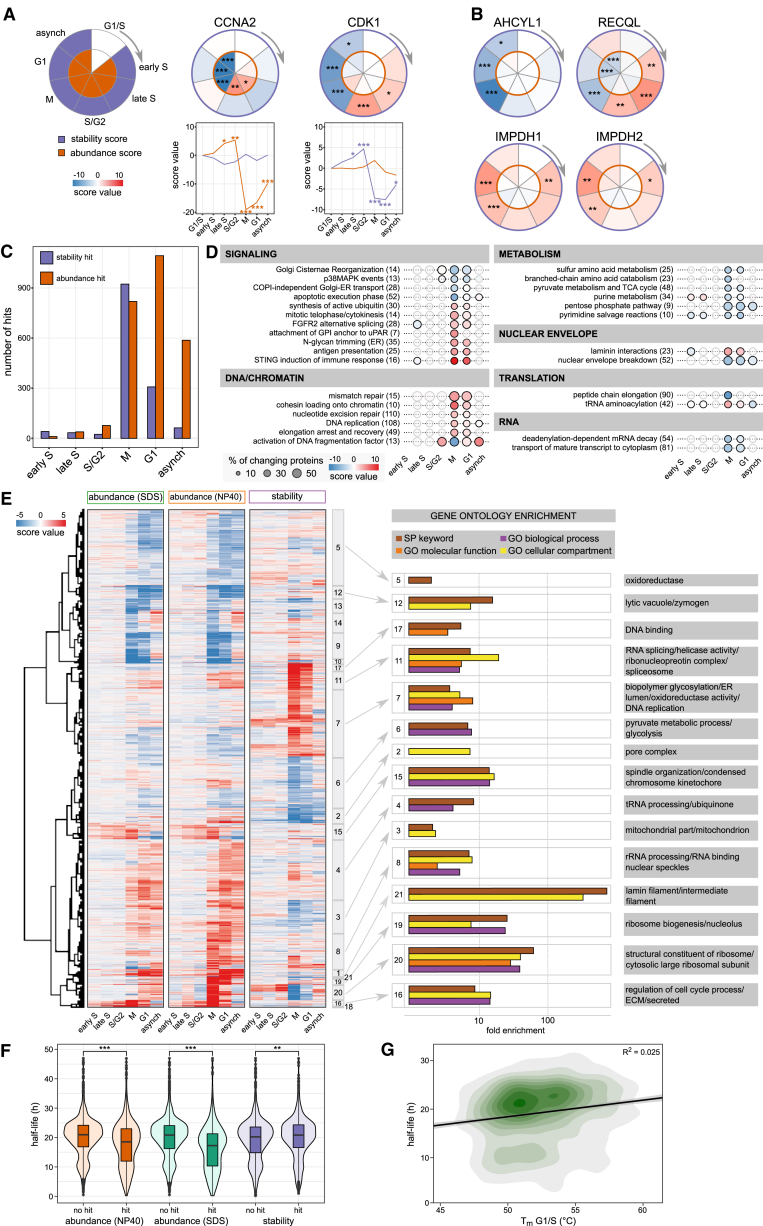
Abundance and Stability Changes of Cell-Cycle Markers, Pathways, and Cell Functions(A) Calculated abundance and stability scores for CCNA and CDK1 in a circular plot. The outer circle represents stability and the inner circle abundance. All data shown in the paper represent three independent biological replicates. ∗p < 0.05, ∗∗p < 0.01, and ∗∗∗p < 0.001, unless otherwise indicated.(B) Cell-cycle-dependent changes in protein stability of AHCYL1, RECQL, IMPDH1, and IMPDH2.(C) Number of significantly affected proteins in either stability (purple) or abundance (orange).(D) Pathways from the Reactome Pathway Database indicate how many proteins are associated with the pathway in general (number in brackets); the percentage of proteins affected in the pathway in at least one cell-cycle stage is correlated with the size of the circle. The color of the circle indicates the mean stability of the pathway components that significantly change in their stability. If the circle is fully opaque, the adjusted combined p value is < 0.05; if the bubble is transparent, then proteins were quantified but did not change in their stability in the respective cell-cycle stage. Pathways are categorized into broader functional groups.(E) Clustering stability and abundance of significantly changing proteins results in 21 individual clusters that were analyzed using DAVID (https://david-d.ncifcrf.gov/) with all quantified proteins as a background. The top result (lowest FDR) for all functional categories (colored as indicated in the legend) is shown for each cluster for which the FDR < 0.05 and linked to the heatmap.(F) Violin plots with the indicated median and interquartile range comparing protein half-life (from Boisvert et al. [2012]) distributions of proteins changing significantly in abundance or stability compared with non-changing proteins. Significance levels obtained from a Wilcoxon signed-rank test were encoded as ∗p < 0.05, ∗∗p < 0.01, and ∗∗∗p < 0.001.(G) 2D density plot of protein half-lives comparison with protein melting points in G1/S phase fitted by a linear model.See also Figures S1 and S2 and Tables S2, S3, S4, and S5.